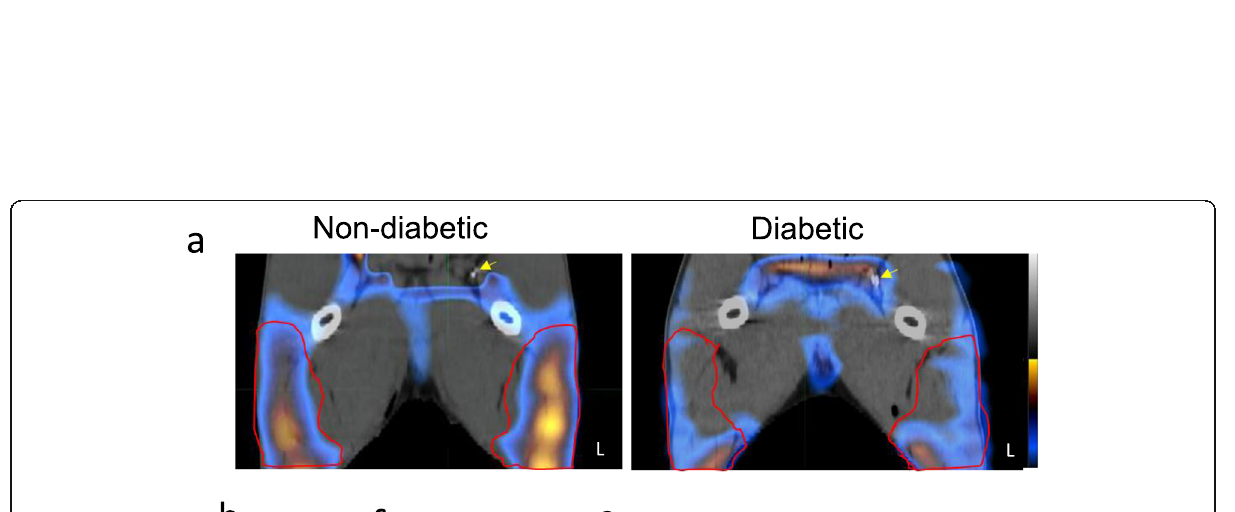
Fig. 2 a Coronal 201 Tl SPECT images of non-diabetic and diabetic pig imaged 24 h after L FAO showing reduced tracer uptake in the occluded limb (yellow arrows) compared to the non-occluded limb. The color scale bar represents counts/unit time. Mean values of ratios of total hindlimb counts for the ischemic/non-ischemic (L/R) limbs for the non-diabetic and diabetic pigs are shown on the images. b Bar graphs of mean ± SD 201 Tl uptake as %IA for the three distal hindlimb muscles for day 1 and day 28 scans for non-diabetic group (left graph) and diabetic group (right graph). c Mean ± SD for the difference in 201 Tl uptake (%IA) in the gastrocnemius between the 2 time points for the two groups. The difference was significant ( P = 0.003). d Individual values for 201 Tl uptake (%IA) at day 1 and day 28 for the gastrocnemius muscle for non-diabetic pig (blue lines) and diabetic pig (orange lines)